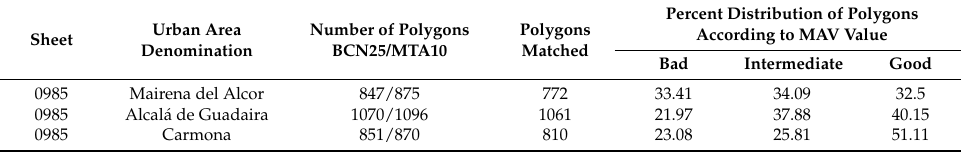
Table 3. Percentage distribution of polygons according to Match Accuracy Value (MAV)